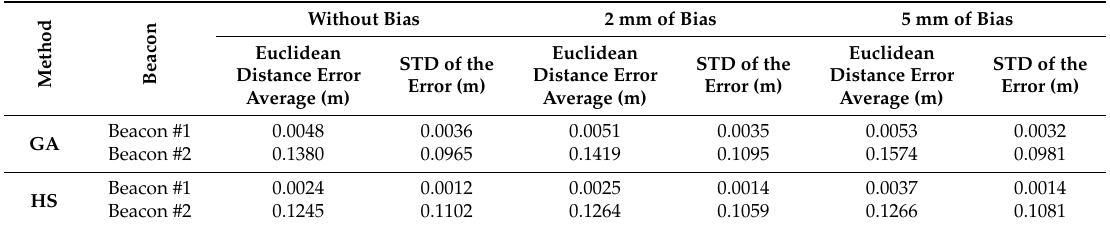
Table 7. Results adding several biases in the distances measured, with a standard deviation equal to 2 mm.